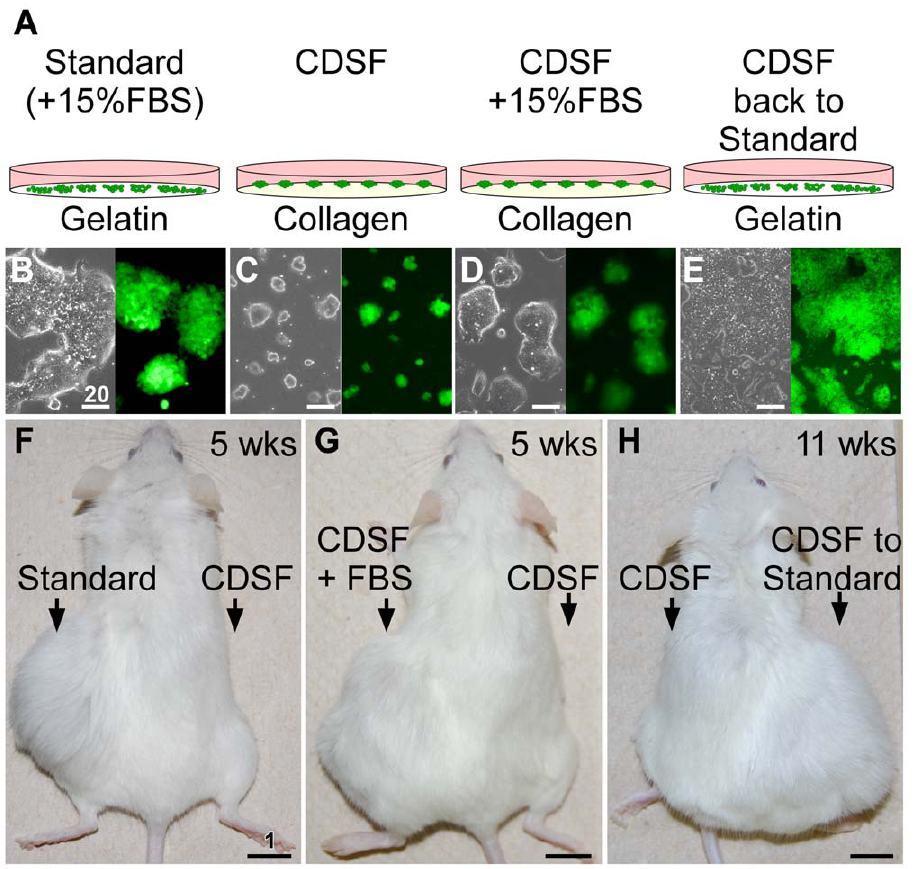
Figure 1. The tumorigenicity of mouse embryonic stem cells can be reduced by short-term serum-free culture. (A): A mouse embryonic stem cell (mESC) line harboring an EGFP reporter driven by the Oct3/4 promoter ( Oct3/4::EGFP ) was maintained in either standard or chemically- defined serum-free (CDSF) medium as indicated. (B–E): Phase contrast (left) and fluorescence (right) images of the ESC line under the conditions indicated above are shown. Bars, 20 m m. (F–H): After the mESCs were cultured as indicated, they were transplanted into NOD-SCID mice subcutaneously. Teratoma formation was observed by week 11. Bars, 1 cm.